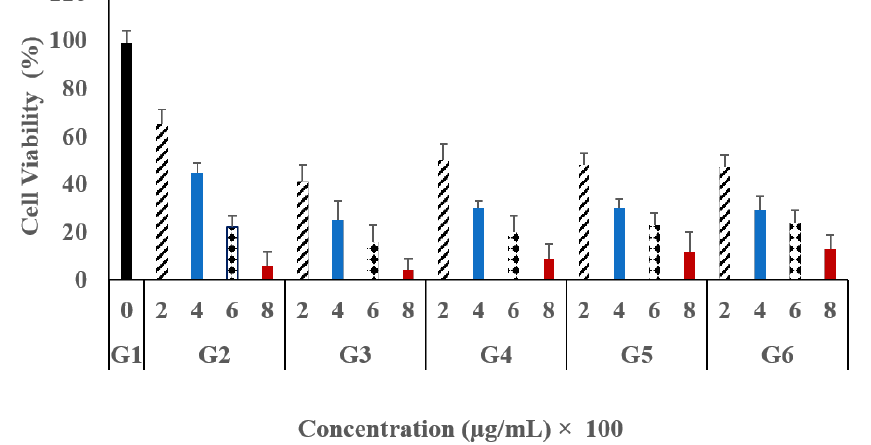
Table 4. The percentage of breast cancer cell viability measurements as a function of concentration for all modified hydrogel systems compared to either free drug solutions or untreated groups.